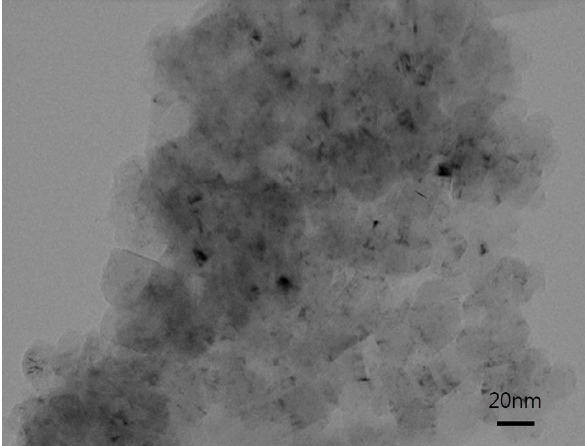
Figure 3: TEM micrographs of the as milled powder for 16 h showing the dispersoid produced by reactive